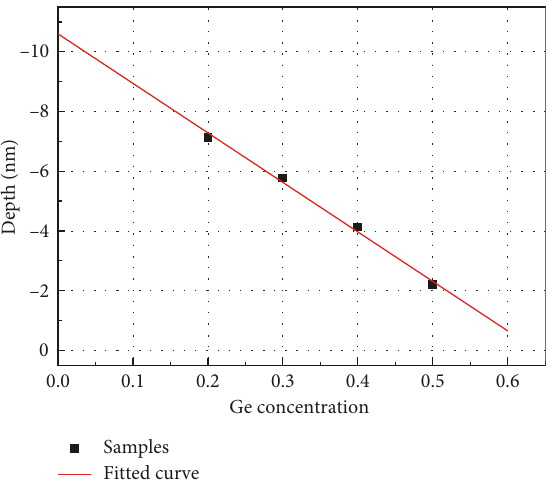
Figure 13: Depth that band gap transition can be achieved under different Ge components.